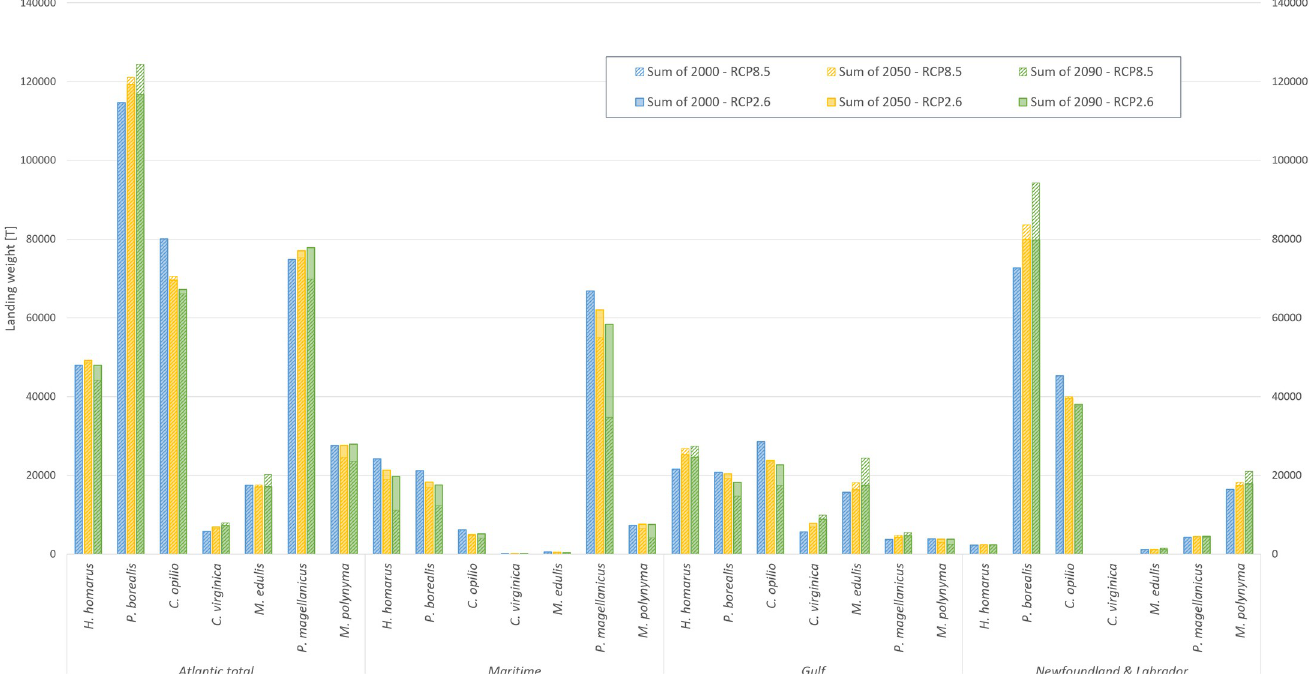
Fig 7. Changes in landing weight for projection scenarios for each species in the three DFO management areas and across the total Atlantic region. Each set of bars from left to right presents the year 2000 catch weight (pale blue), 2050 projected catch (yellow), and 2090 projected catch (green). Sections of each bar with diagonal hashes denote the RCP 8.5 climate scenario projections; the solid (semi-transparent) sections indicate the RCP 2.6 projections. The projected changes for the total regional landings are based on the relative change calculated across the whole study region and therefore do not present the sum of the projected landings from the individual management areas. DBEM relative change projections as percent change for each species in each time-step/climate scenario are available in S1 Table.